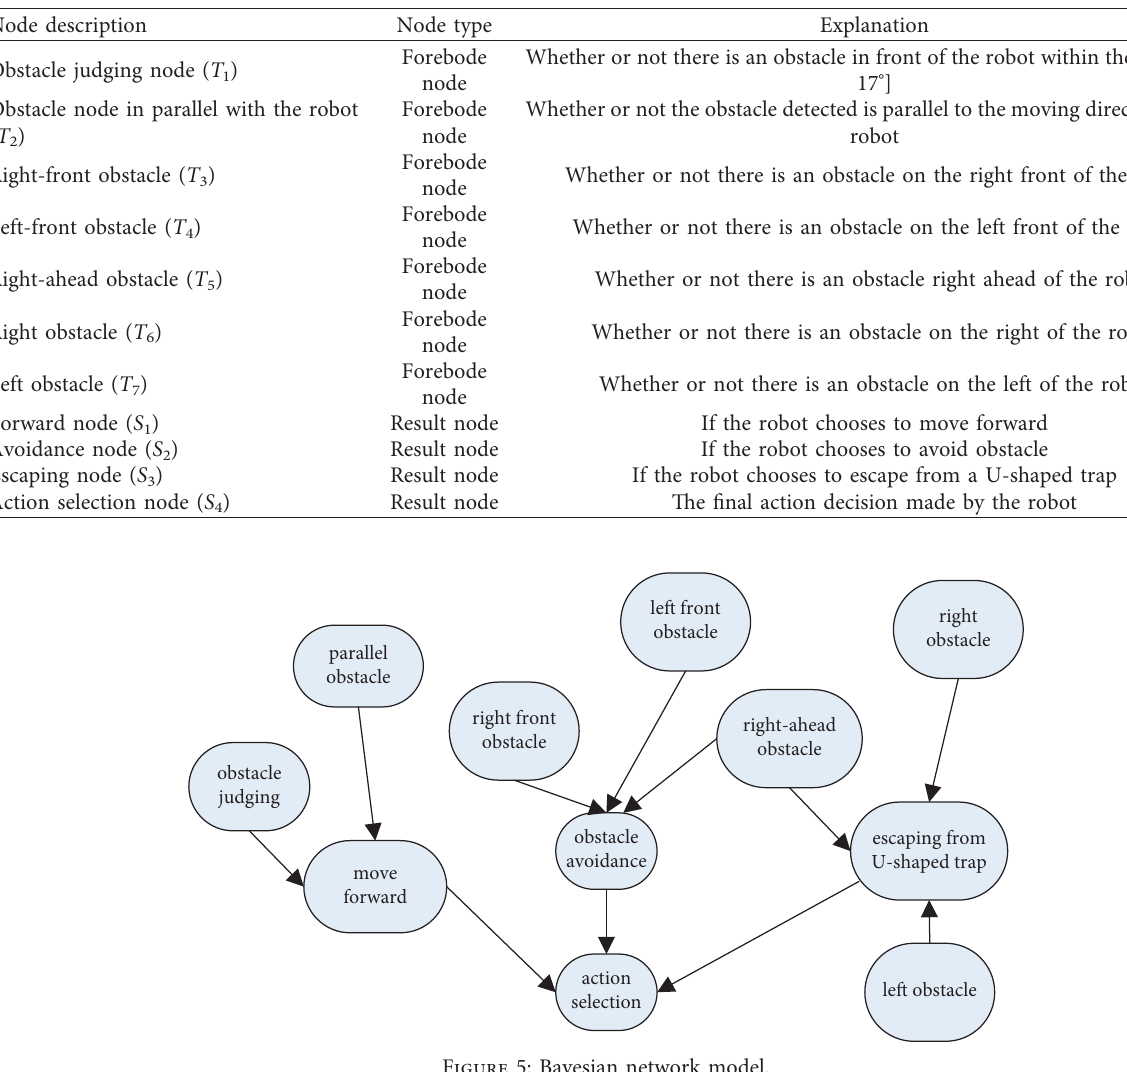
Table 1: Robot action selection based on Bayesian network model.